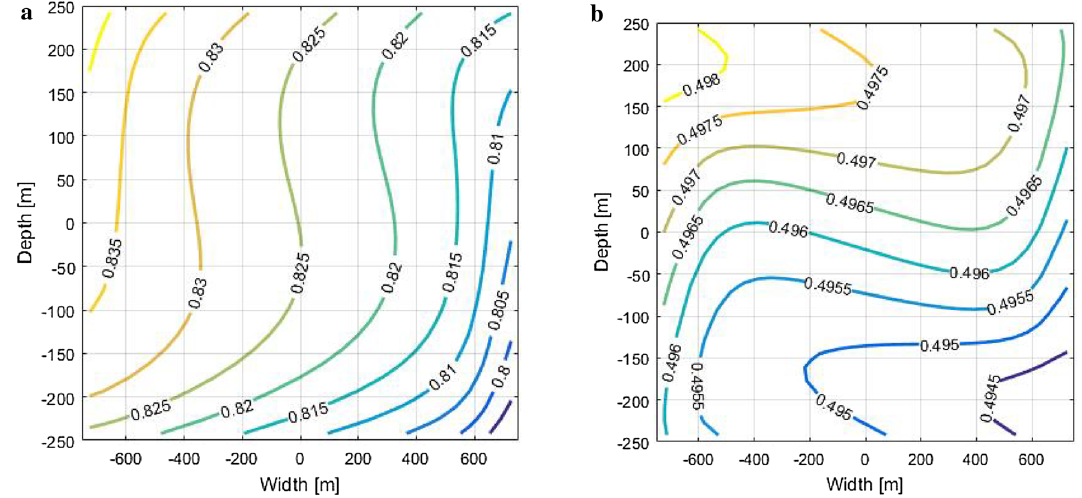
Fig. 11 a Contour plot of C 1 composition, with natural convection, convection, k = 1 md, volatile